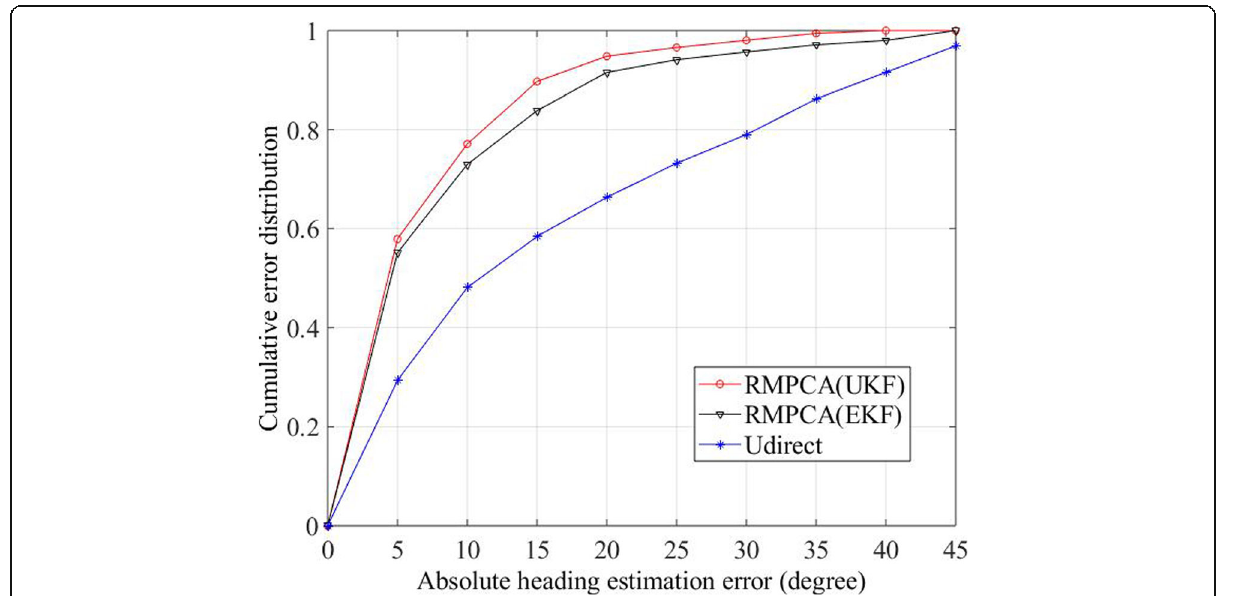
Fig. 3 Absolute heading estimation error distribution comparisons. The compared approaches include uDirect approach and RMPCA approaches using UKF and EKF for attitude tracking, respectively